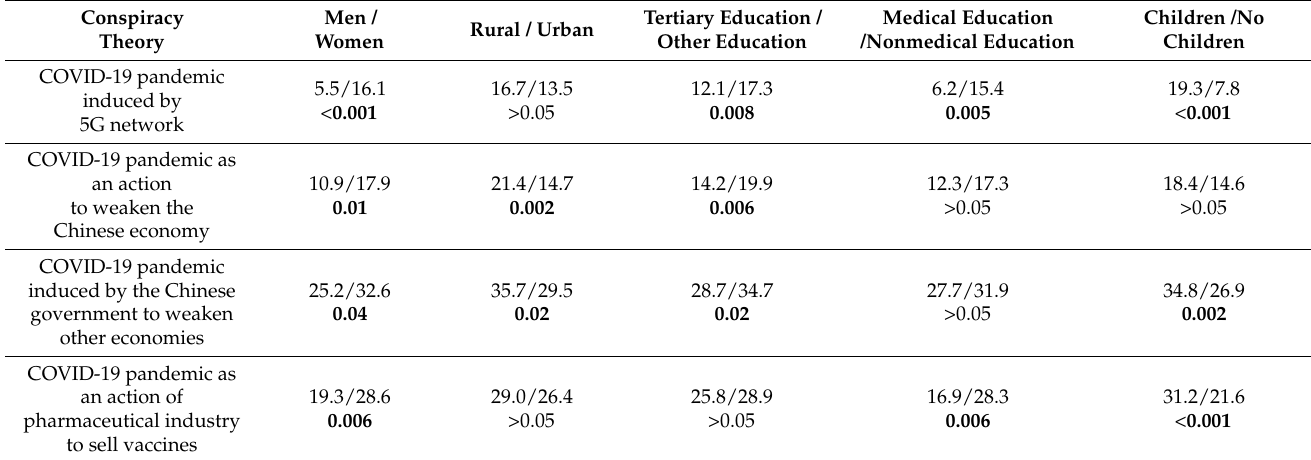
Table 4. The frequency (%) of beliefs in conspiracy theories on COVID-19 in different subgroups of the studied population ( n = 1337). p -value indicating significant differences is given in bold (Pearson’s χ 2